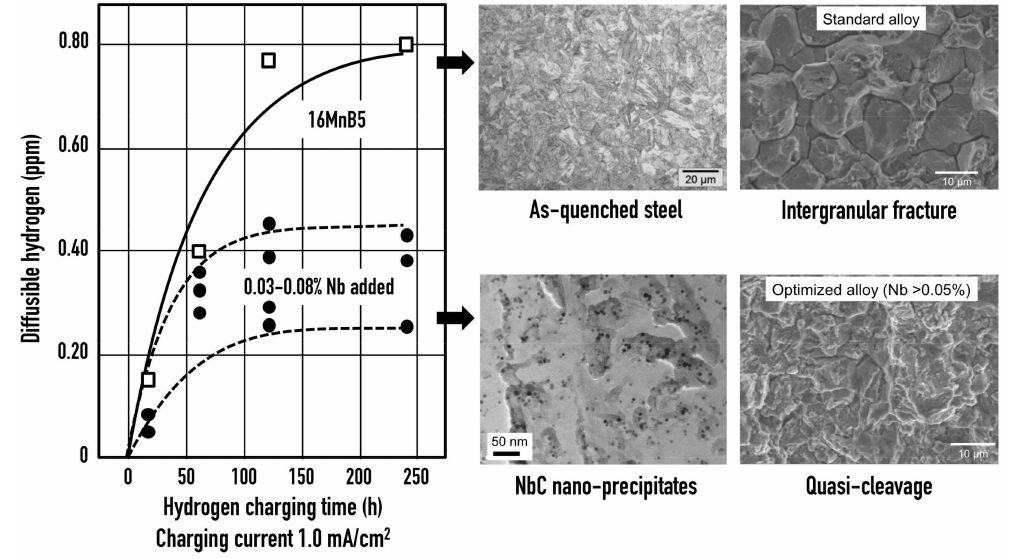
Figure 15. Amount of diffusible hydrogen in 16MnB5 measured by thermal desorption analysis (TDA) and influence of niobium microalloying; microstructural features and fracture surface after constant load